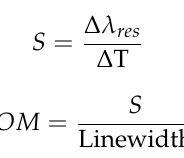
Figure 4. ( a ) Design parameters vs. Linewidth; ( b ) Design Parameters vs. Quality